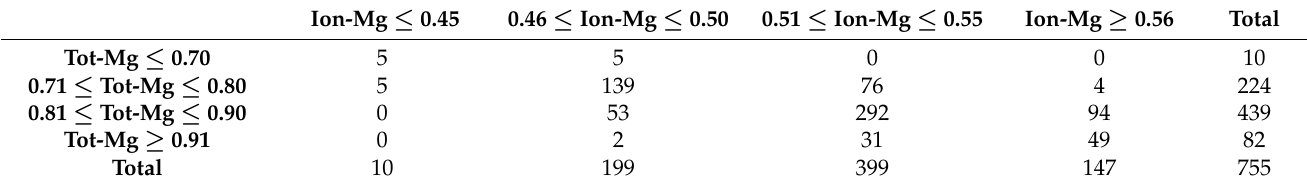
Table 1. Comparisons between total magnesium and ionized